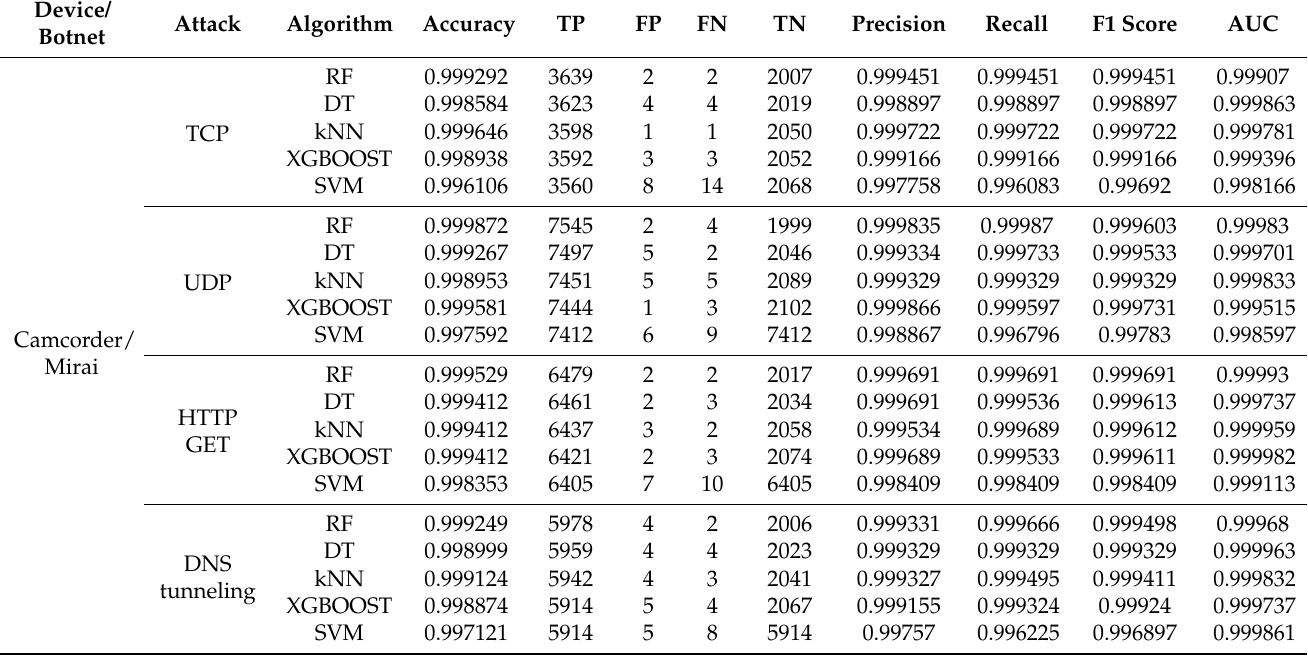
Table 17. Classification results